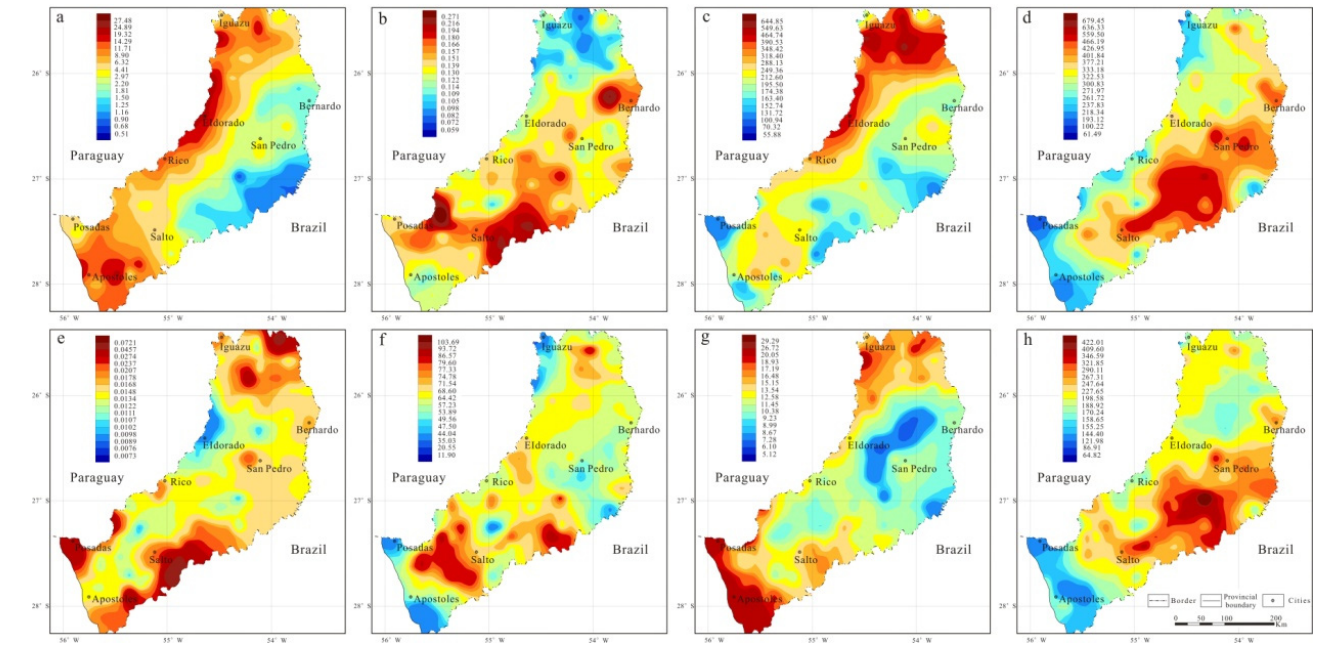
Figure 2. Geochemical maps of As ( a ), Cd ( b ), Cr ( c ), Cu ( d ), Hg ( e ), Ni ( f ), Pb ( g ) and Zn ( h ). Table 6. Pearson correlation coefficients between heavy metals in stream sediments. Elements